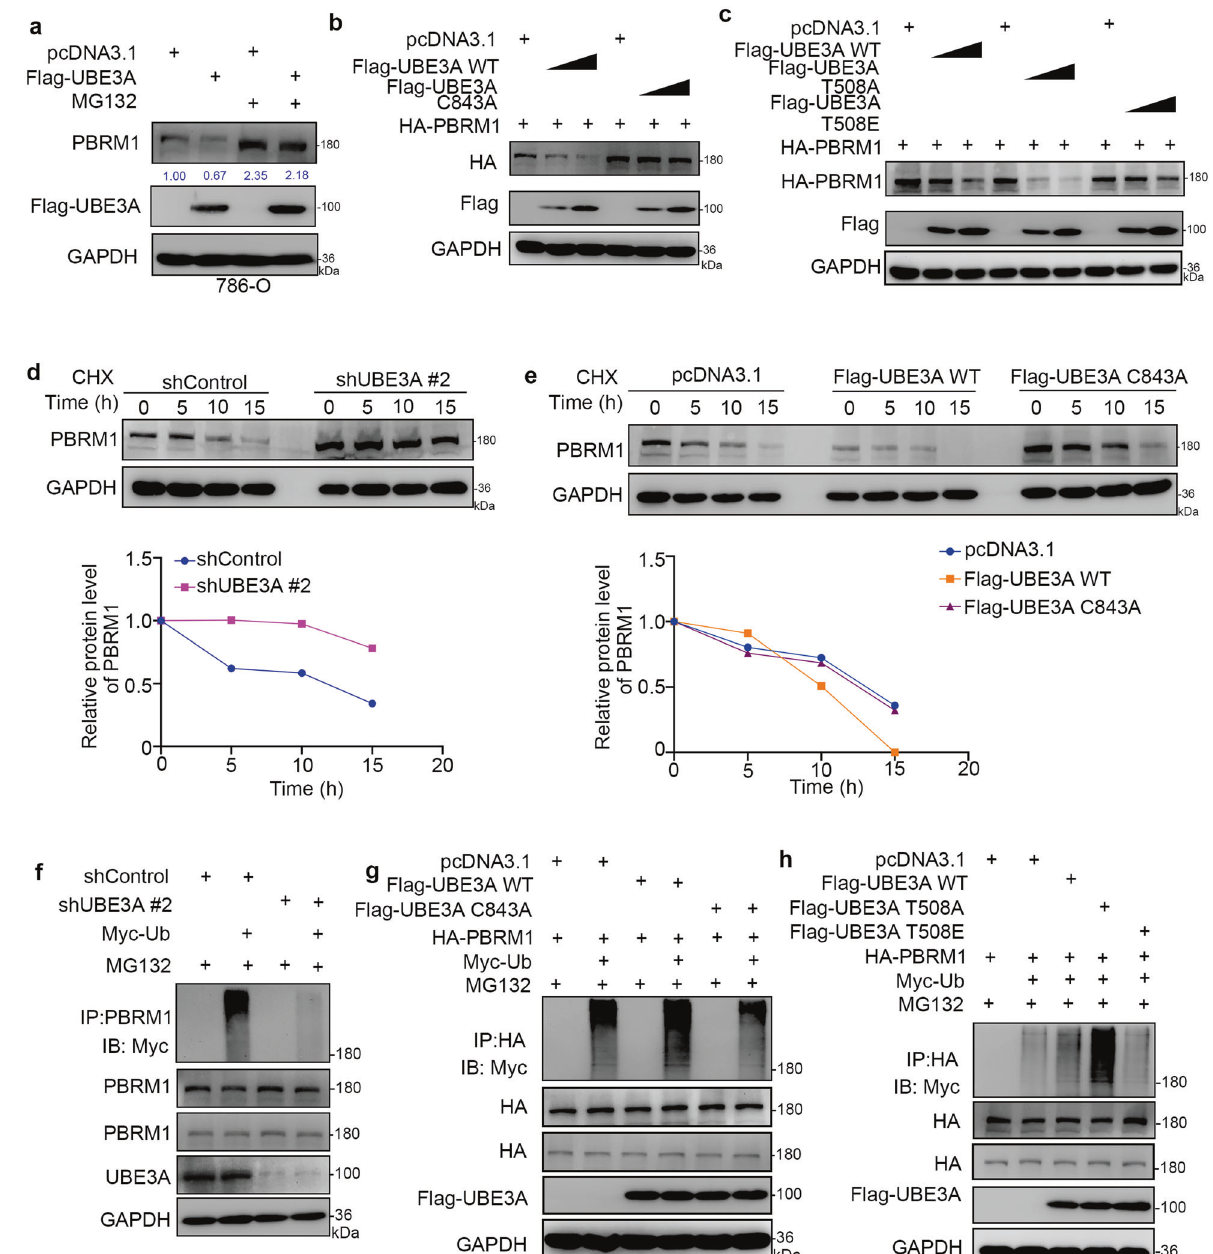
Fig. 2 UBE3A promotes PBRM1 degradation in renal cancer cells. a 786-O cells were transfected with indicated plasmids for 24 h. Before harvested for western blotting analysis, cells were treated with or without 20 µM MG132 for 6 h. b 786-O cells were transfected with indicated plasmids. Twenty-four hours post transfection, cells were harvested for western blotting analysis. c 786-O cells were transfected with indicated plasmids. Twenty-four hours post transfection, cells were harvested for western blotting analysis. d 786-O cells were infected with indicated shRNAs. After 72 h, cells were treated with cycloheximide (CHX), and cells were collected for western blot analysis at different timepoints. e 786-O cells were transfected with indicated plasmids. After 24 h, cells were treated with CHX, and cells were collected for western blot analysis at different timepoints. f 786-O cells were infected with the indicated shRNAs. After 72 h, cells were collected for western blotting after treatment with MG132 for 8 h. g 786-O cells were transfected with the indicated plasmids. After 24 h, cells were collected for Western blotting after treatment with MG132 for 8 h. h 786-O cells were transfected with the indicated plasmids. After 24 h, cells were collected for western blotting after treatment with MG132 for 8 might promote PBRM1 degradation in renal cancer cells. To test knockdown of UBE3A increased the PBRM1 protein levels, but this hypothesis, UBE3A plasmids were transfected into the 786-O overexpression of UBE3A reduced the PBRM1 expression in cells treated with or without 26 S proteasome inhibitor MG132. 293T cells (Supplementary Fig. 2c, 2d). Meanwhile, we also Consistent with this hypothesis, ectopically overexpressed UBE3A showed that the protein level of UBE3A was negatively correlated resulted in the downregulation of PBRM1 expression, and this with the PBRM1 protein level in the renal cancer patient process could be attenuated by MG132 treatment (Fig. 2a), which specimens (Fig. 1i, k). Therefore, we hypothesized that UBE3A